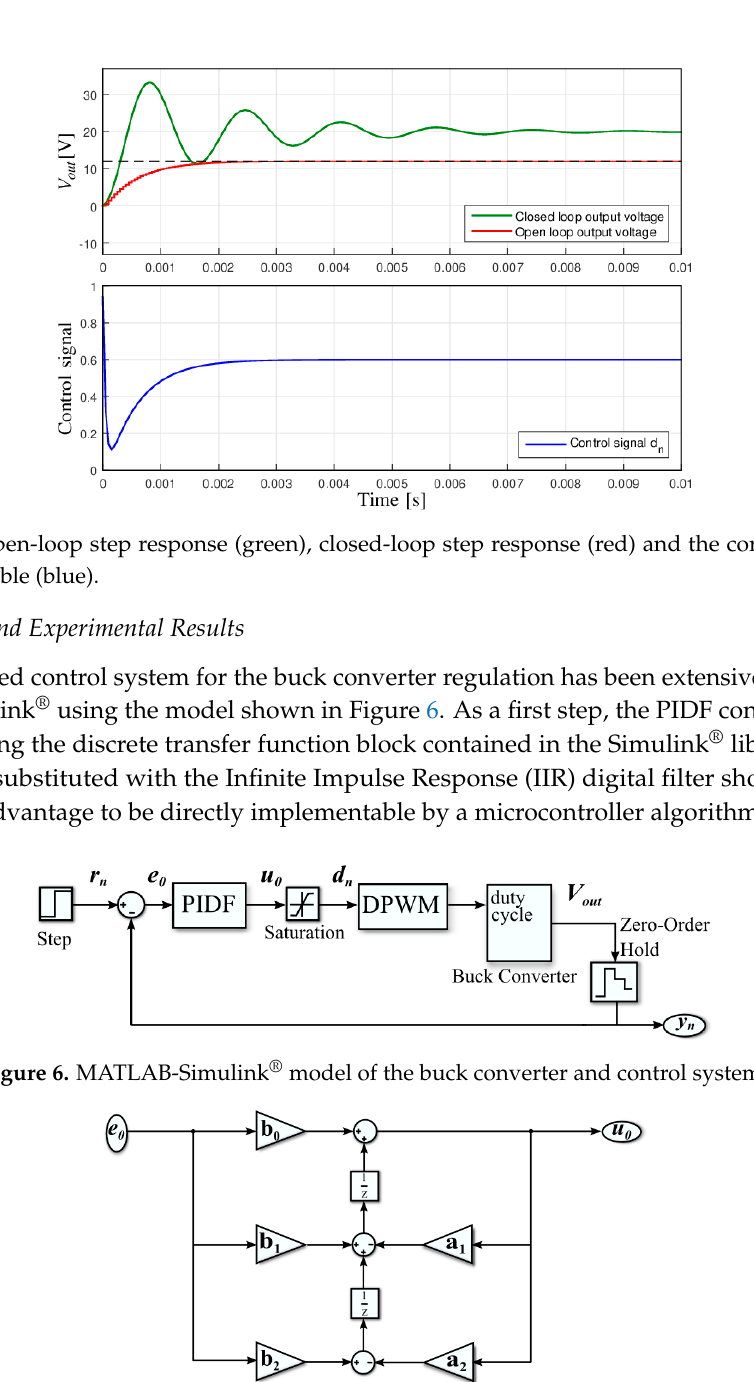
Figure 4. Bode diagrams of the frequency response of the buck converter (green), and of the open loop frequency response with the discrete-time inversion formulae (red).